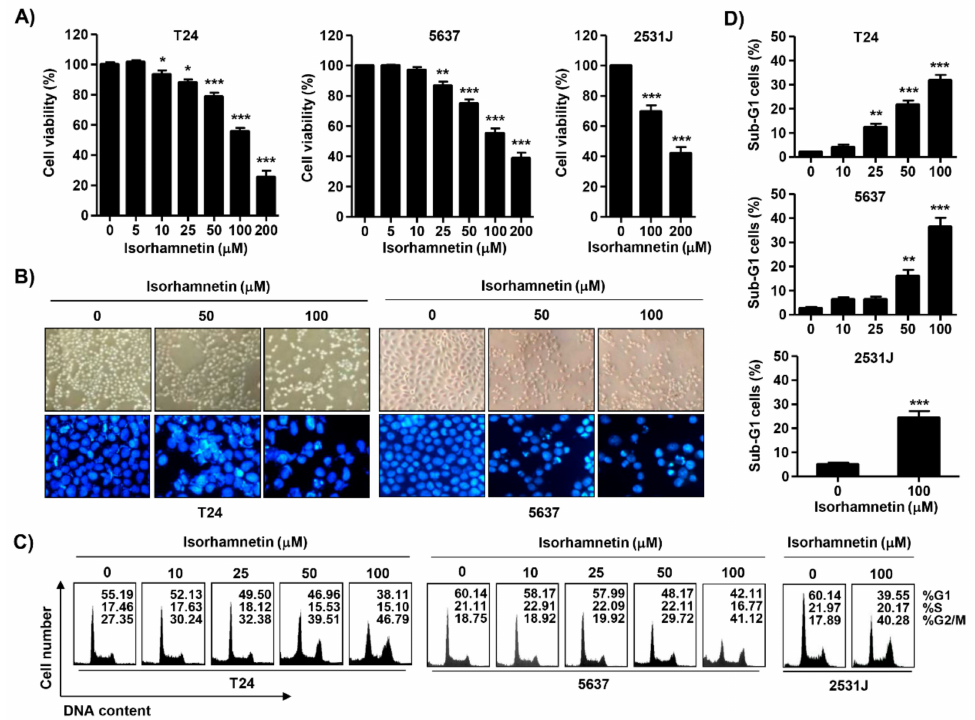
Figure 1. The inhibition of cell viability and induction of cell cycle arrest at gap 2 / mitosis (G2 / M) phase using isorhamnetin in bladder cancer cells. T24, 5637, and 2531J cells were treated with the indicated concentrations of isorhamnetin for 48 h. ( A ) The cell viability was assessed using 3-(4,5-dimethyl-2-thiazolyl)-2,5-diphenyltetra-zolium bromide (MTT) assay. Each bar represents the mean ± standard deviation (SD) of three independent experiments (* p < 0.05 and *** p < 0.0001 compared to the control). ( B , Upper panel) Morphological changes of T24 and 5637 cells were observed using phase-contrast microscopy. (B, Lower panel) The 4 (cid:48) ,6-diamidino-2-phenylindole (DAPI)-stained nuclei were pictured under a fluorescence microscope. Representative photographs of the morphological changes are presented. ( C , D ) The cells were stained with propidium iodide (PI) solution for flow cytometry analysis. Quantification of the cell population (in percent) in di ff erent cell cycle phases of viable cells is shown. (D) Sub-G 1% was calculated as the percentage of the number of cells in the sub-G1 population relative to the number of total cells. Data were expressed as the mean ± SD of three independent experiments (* p < 0.05, ** p < 0.001, and *** p < 0.0001 compared to the